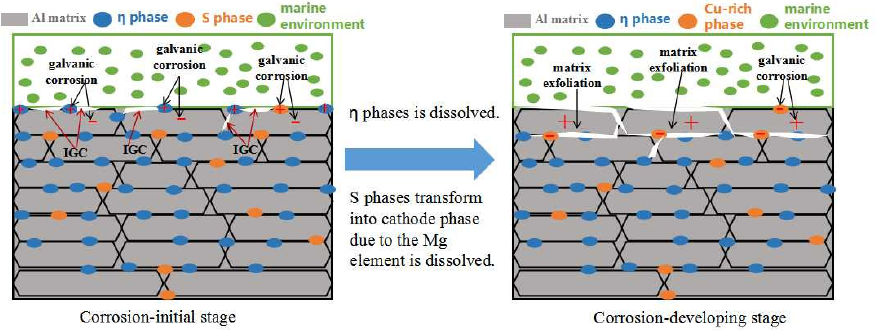
Figure 8. Sketch of the corrosion processes of the 7075 alloy’s exposure to the marine environment.